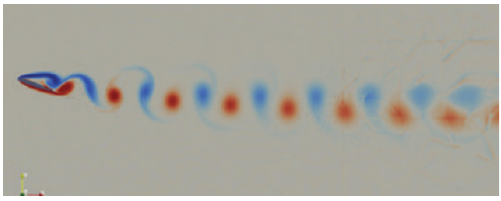
Figure 3: Karman vortex street for Re = 800 and t =